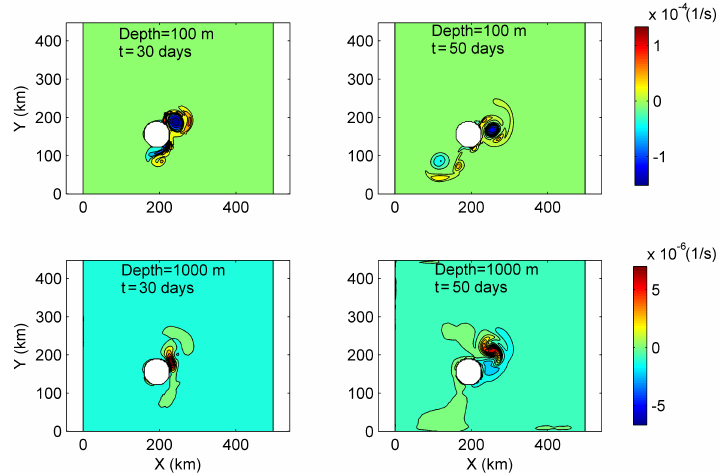
Figure 9. The potential vorticity anomaly (PVA) distributions of the interaction between the warm eddy (anticyclonic eddy) and the island of 60km in diameter at 100m (upper panels) and 1000m (lower panels) at day 30 and 50. The colours represent the PVA and the solid lines being the PVA contours.